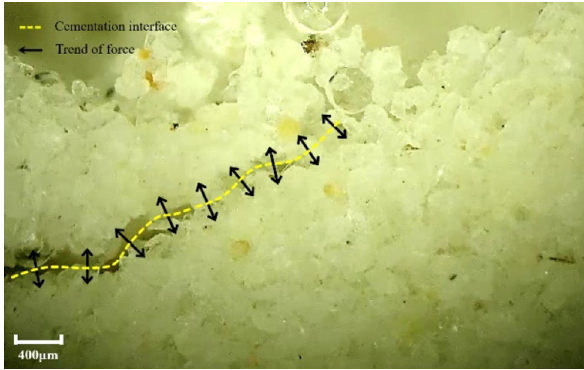
Fig. 16 The discrete particle detachment form near the fluid outlet side of the No.2 sample